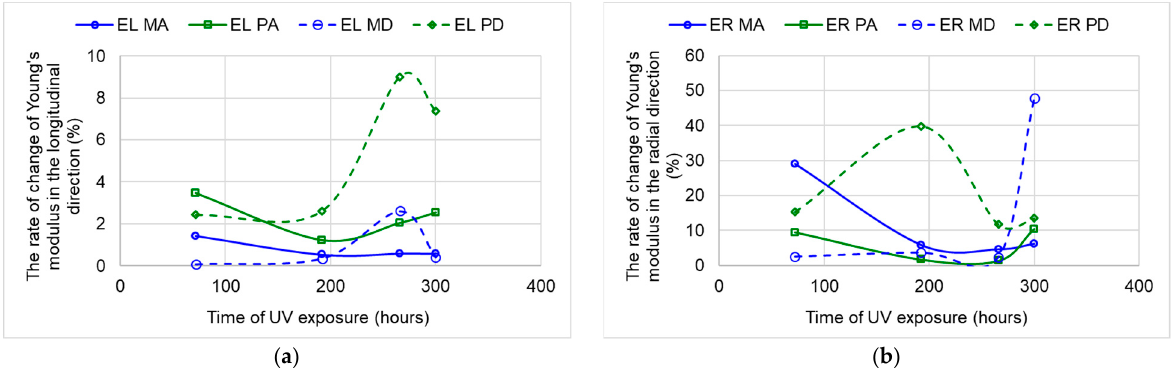
Figure 16. The rate of change in the Young’s modulus with exposure time: ( a ) in the longitudinal direction; ( b ) in the radial direction.